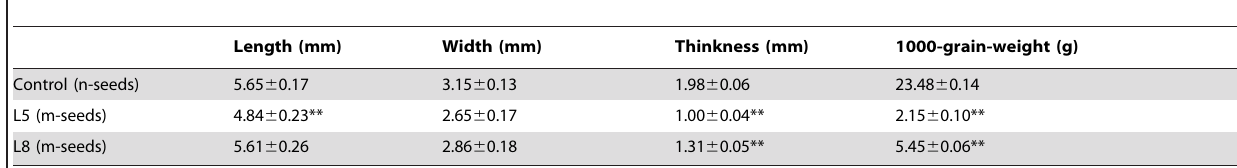
Table 1. Agronomic traits of seeds in control plants and OsMADS29 RNAi transgenic